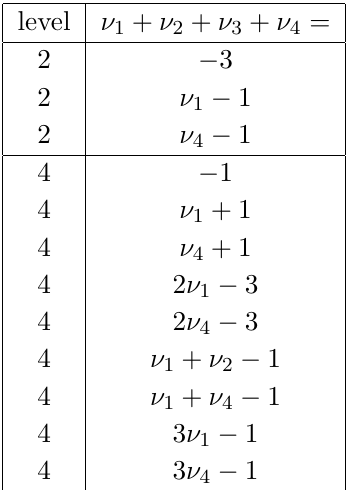
Table 5 . Truncation curves of the orthosymplectic family of algebras at levels 2 and 4. Out of all curves related by the triality symmetry permuting (cid:23) 1 ; (cid:23) 2 and (cid:23) 3 we list only one. The parameter (cid:23) 4 equals (cid:0)